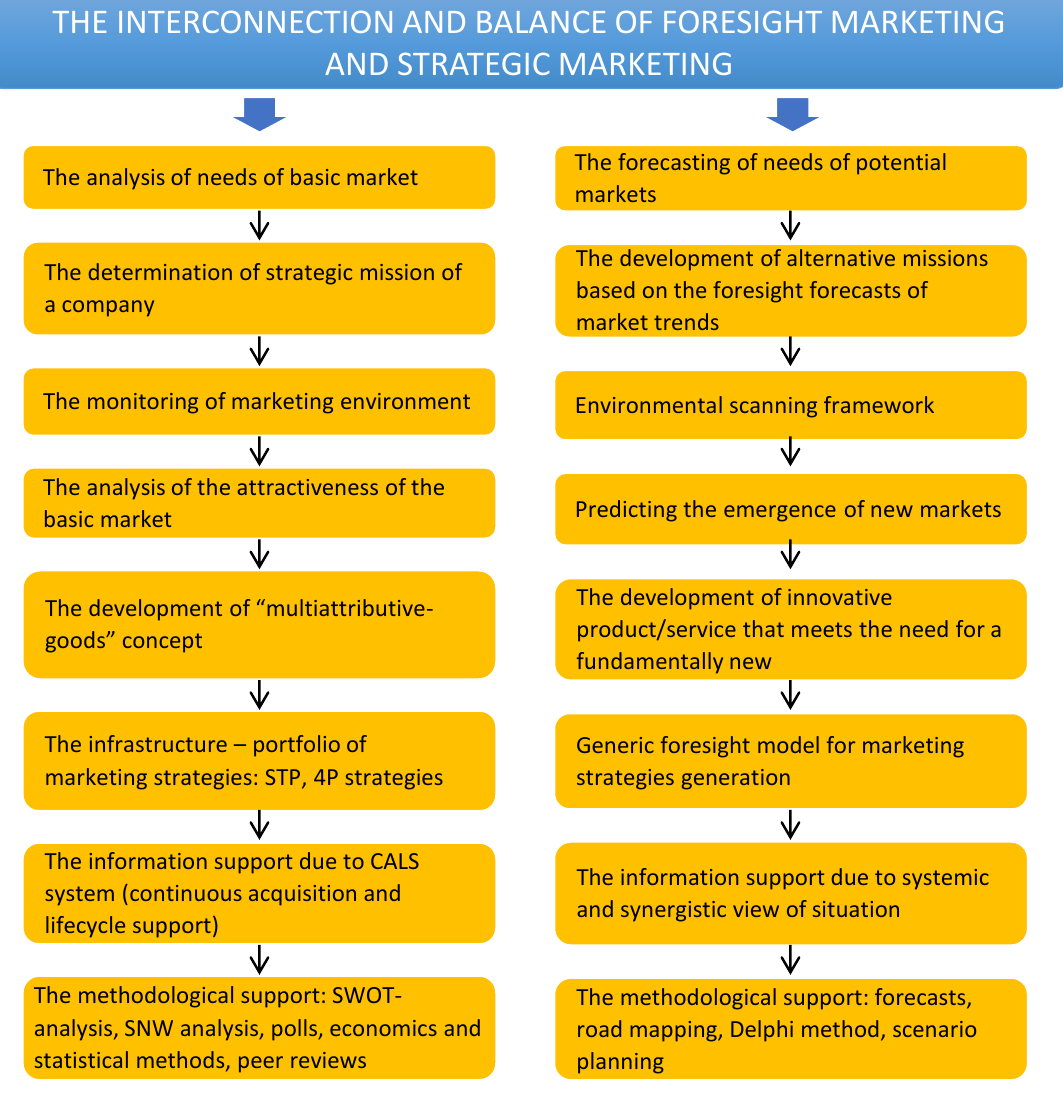
Figure 2. The interconnection and balance of foresight marketing and strategic